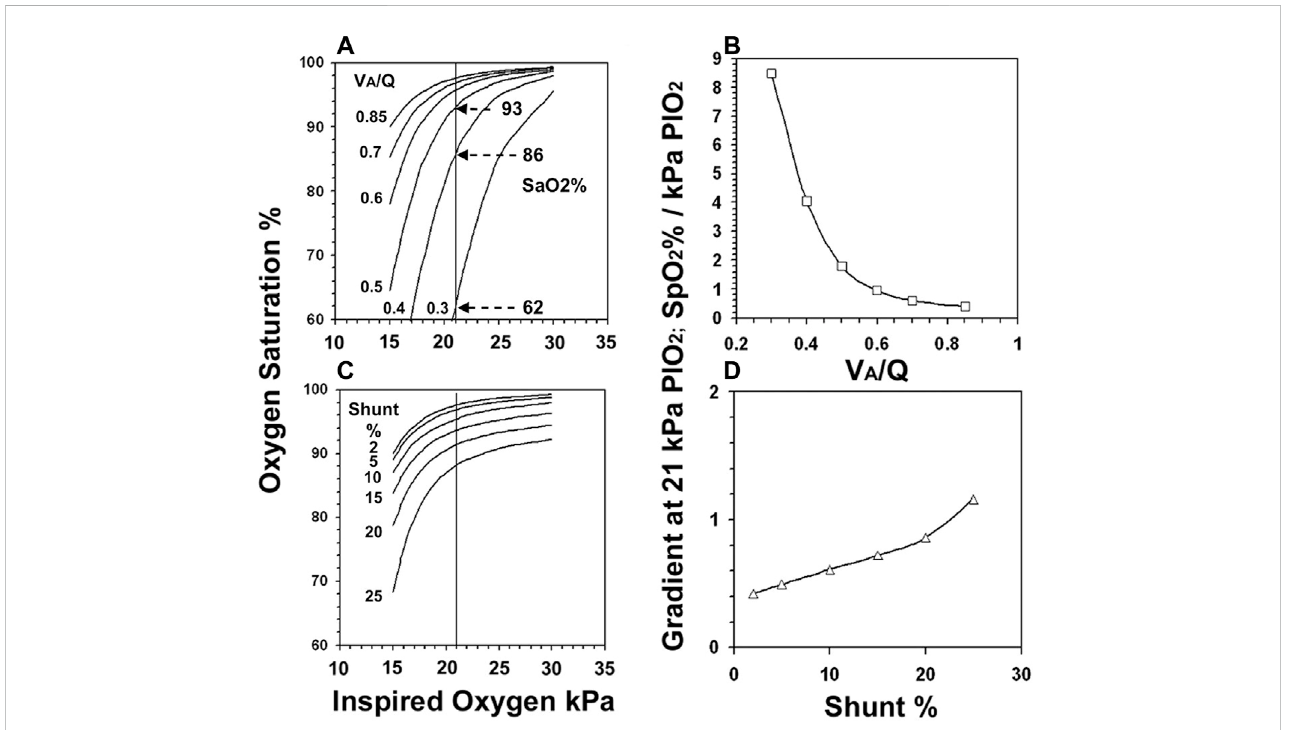
FIGURE 2 The gas exchange model derived P I O 2 vs. SaO 2 curves when V A /Q was reduced from 0.85 to 0.3. (Figure 2A). The slope of the curve as it intercepted the 21 kPa P I O 2 line is shown for V A /Q (Figure 2B). The P I O 2 vs. SaO 2 curves when shunt increased from 2% – 25% (Figure 2C) and their slopes (Figure